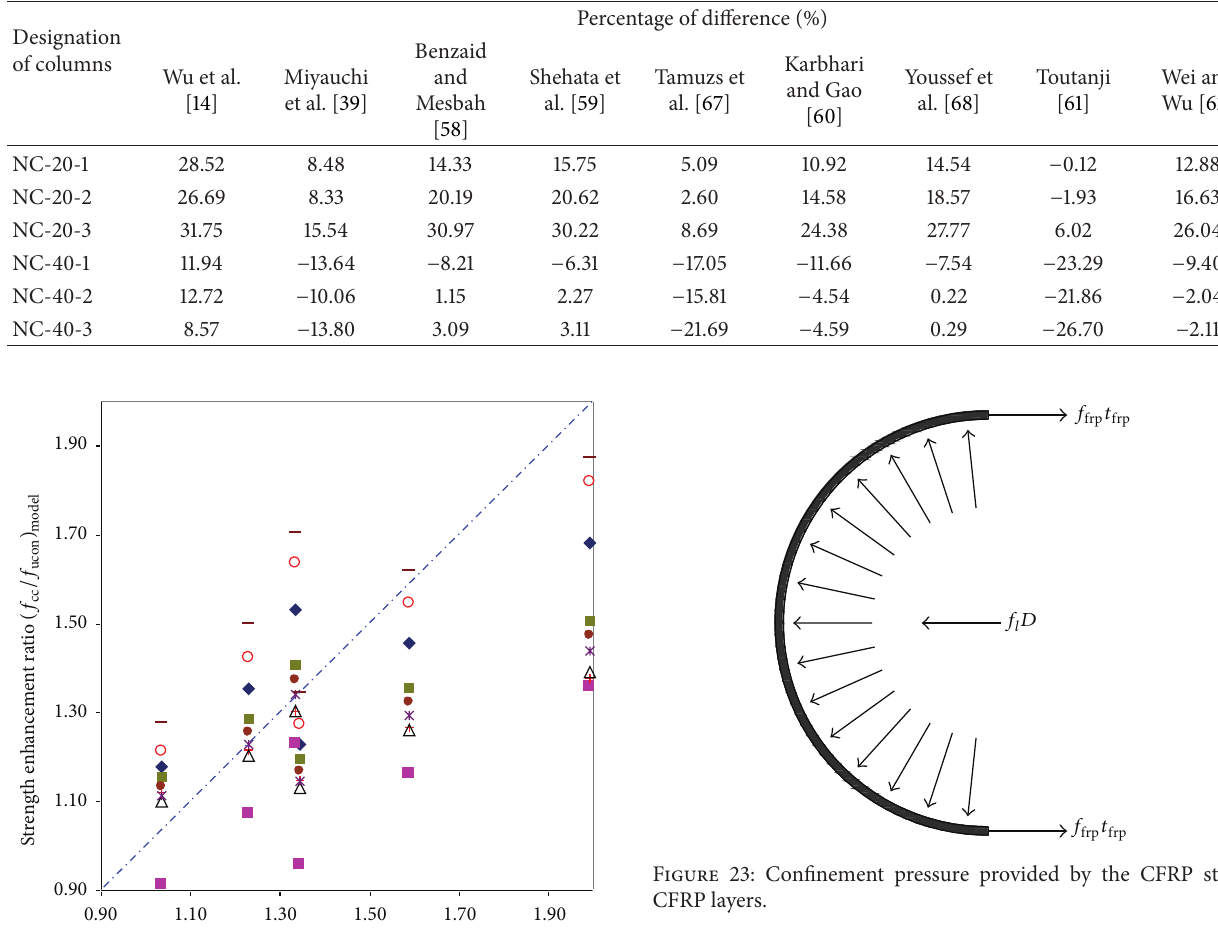
Table 4: Percentage of error (PE) of some models used to predict the peak axial strength of concrete columns.